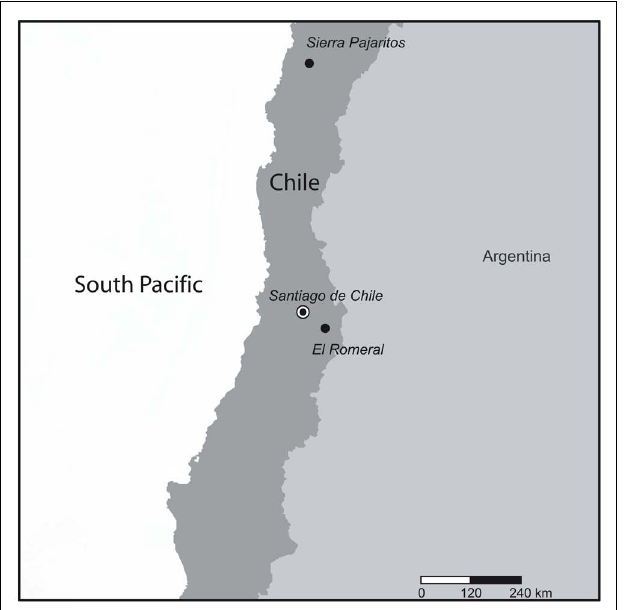
FIGURE 1 | Sampling region at “El Romeral,” Cajón del Maipo (semiarid matorral soil), and “Sierra Pajaritos”Atacama Desert (arid subdesert soil) in